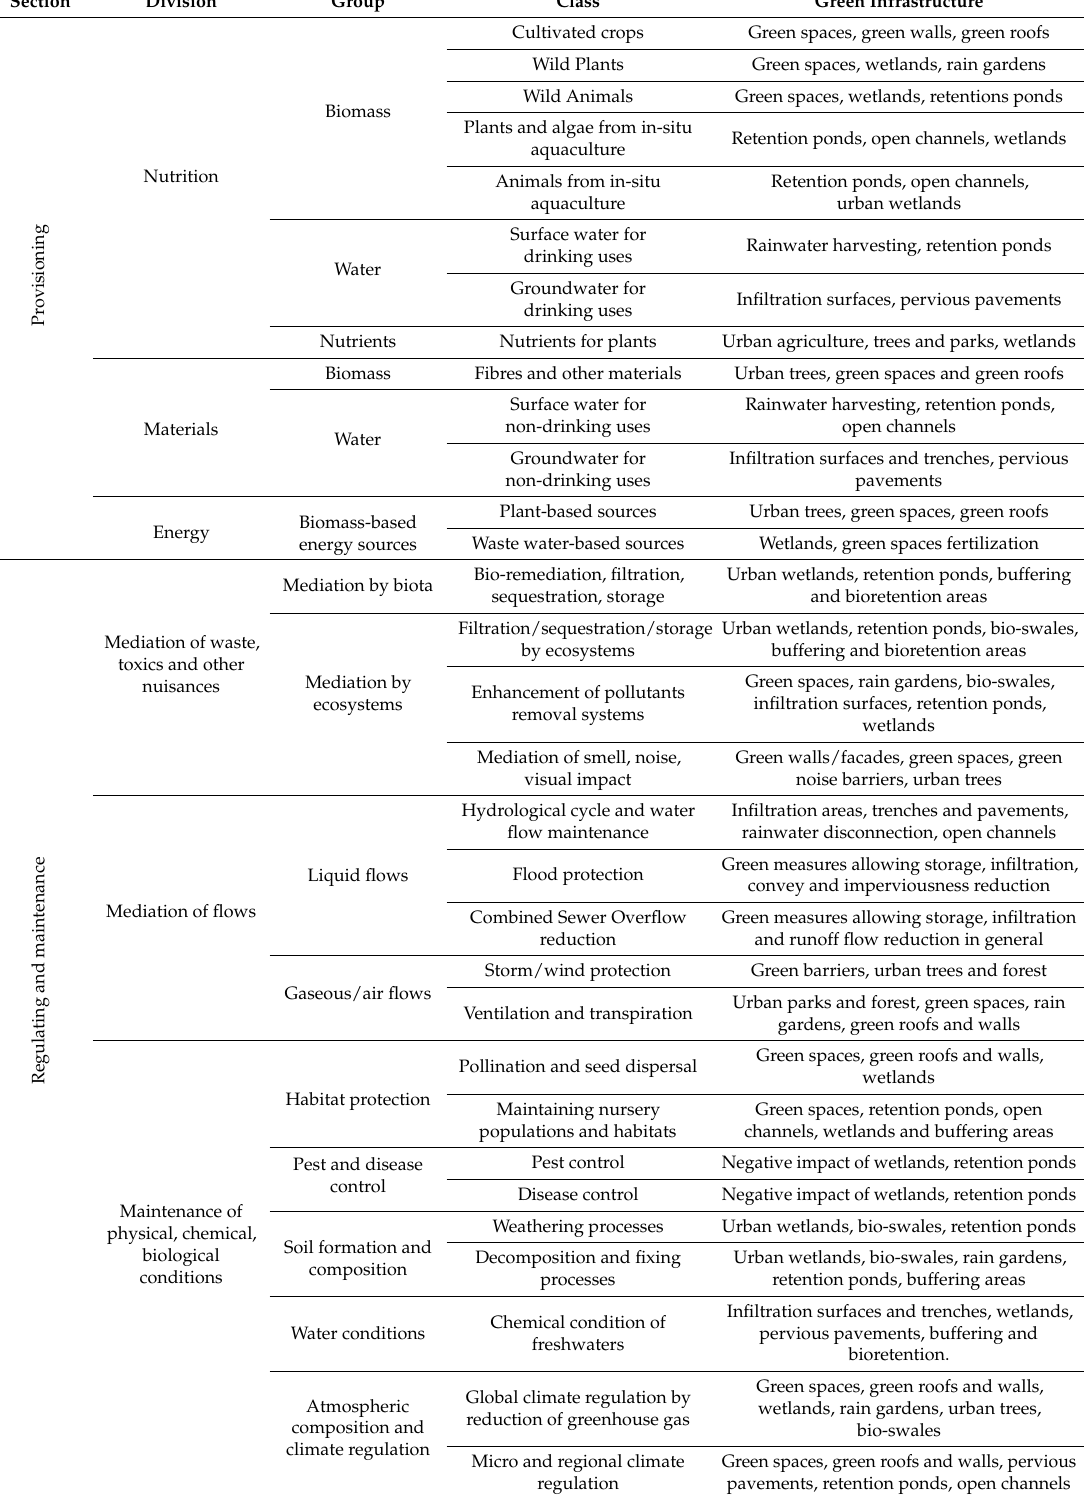
Table 1. Ecosystem service (ES) classification (based on [25]) and examples of green infrastructure providing these services